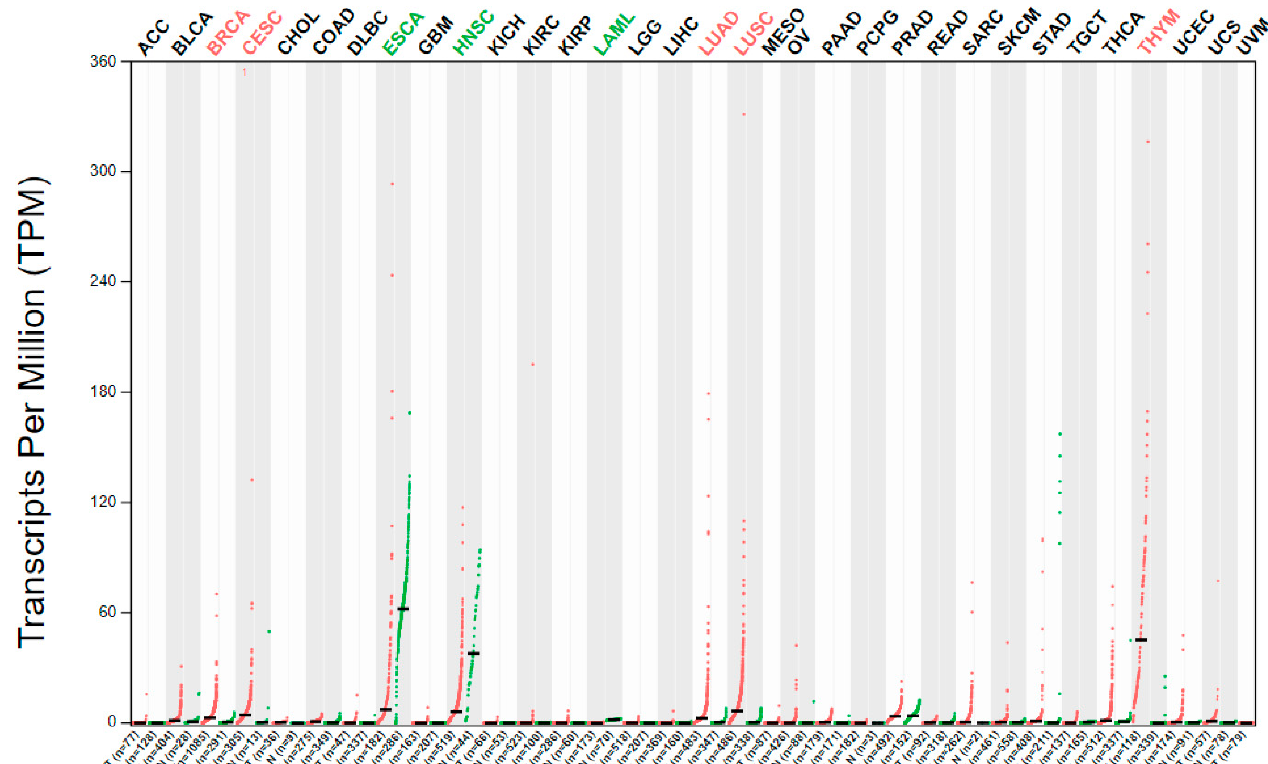
Figure 2. Differential expression of PAX9 mRNA in cancer and corresponding normal tissues (http://gepia.cancer-pku.cn/) (accessed on 22 March 2022). RED indicates significant PAX9 overexpression in BRCA, CECS, LUAD, LUSC, and THYM, and GREEN significant downregulation in ESCA, HNSC, and LAML, as compared to corresponding normal tissues. T—tumor tissue; N—